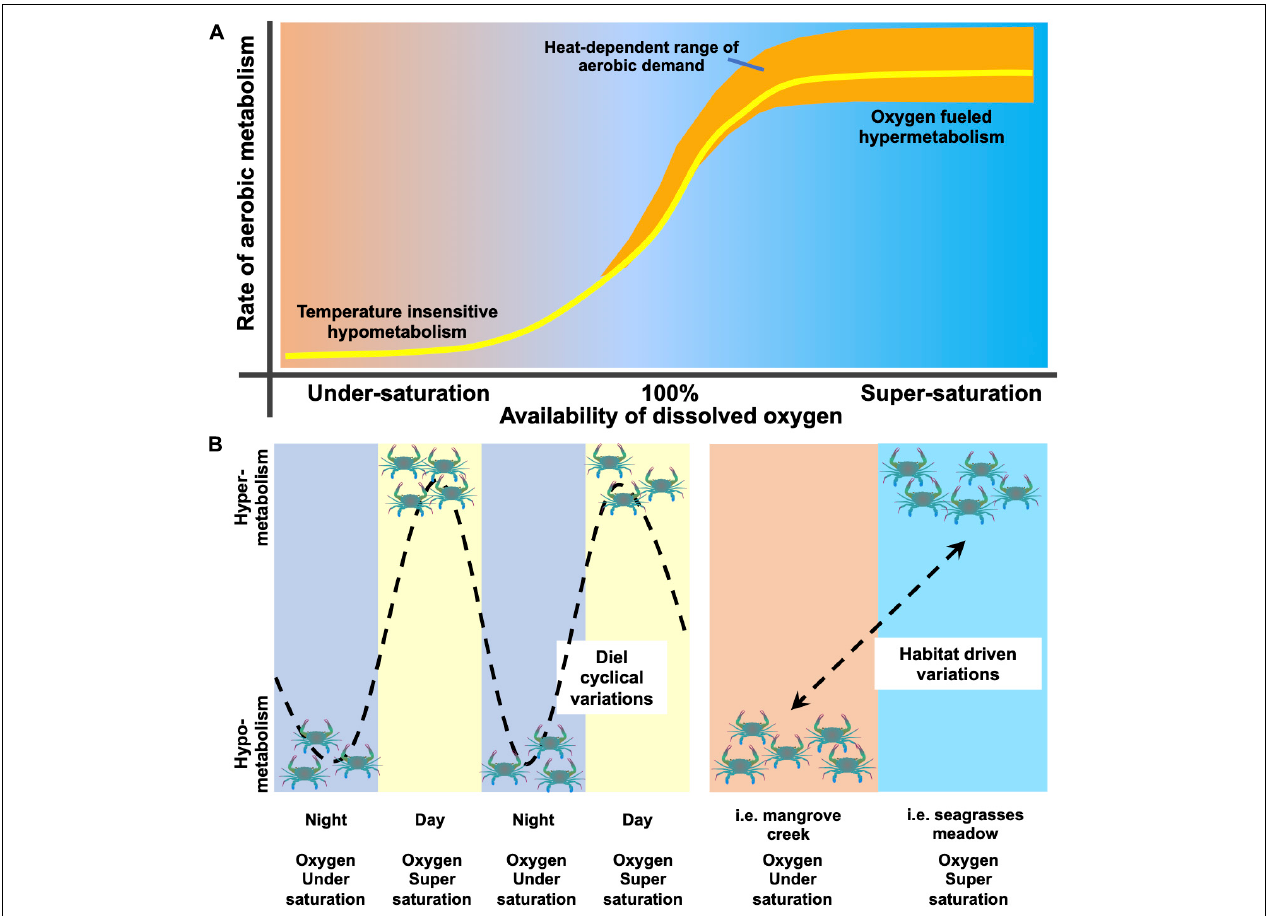
FIGURE 5 | Conceptual model of oxygen availability dependence of aerobic metabolism. Panel (A) summarizes the variation of aerobic metabolism (yellow line) of T. crenata as a function of the amount of dissolved oxygen in the environment and the heat-induced increase of aerobic demand and thermal tolerance to high temperatures (orange shaded area). Panel (B) illustrates two cases of variation of aerobic metabolism, either cyclical (left side of the panel; Giomi et al., 2019) or habitat driven (right side of the panel; this study). Further explanations are provided in the